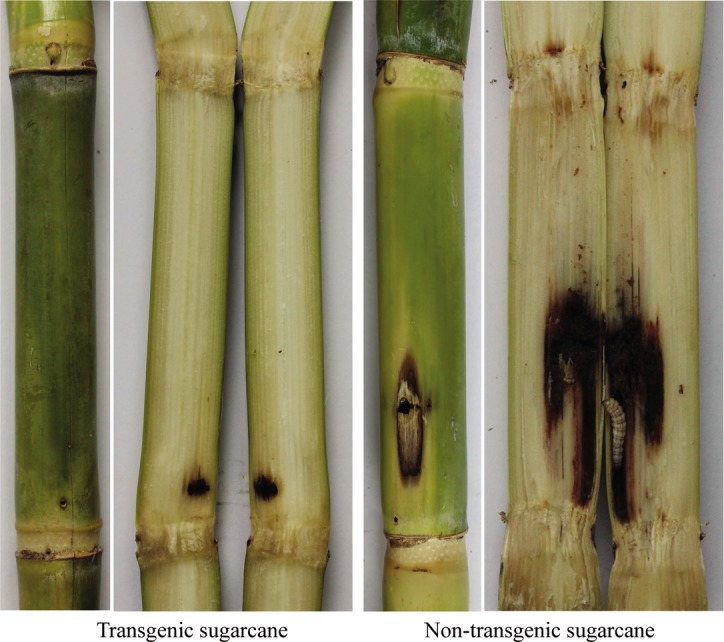
Damage comparison between transgenic and non-transgenic sugarcane stalks.